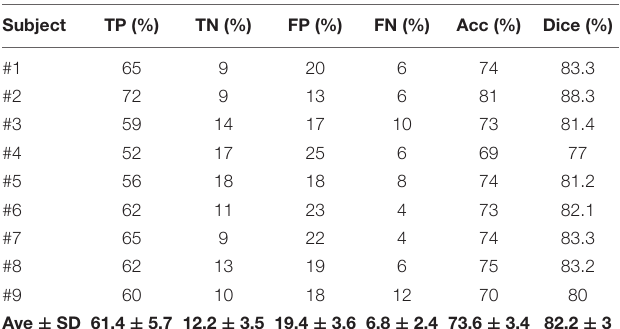
TABLE 4 | Voxel-wise correspondence of resting-state CVRe and breath-hold CVR. Voxel-wise correspondence of resting-state and breath-hold CVR